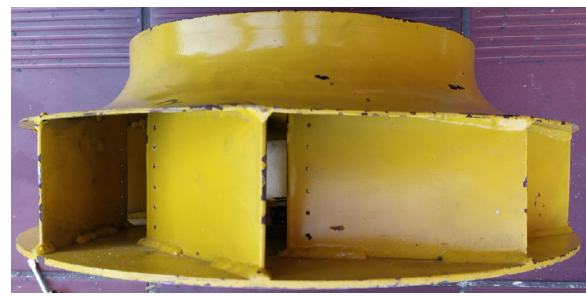
Fig. 6. Radial fan impeller with slots